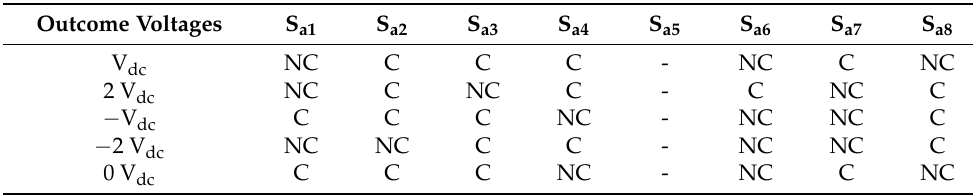
Figure 5. Schematic of the proposed fault-reconfiguration technique in a three-phase 5-level symmet- ric RSMLI fed induction motor drive system under faulty conditions. Table 2. Novel reconfiguration switching sequences of proposed 5-level symmetric RSMLI structure in faulty